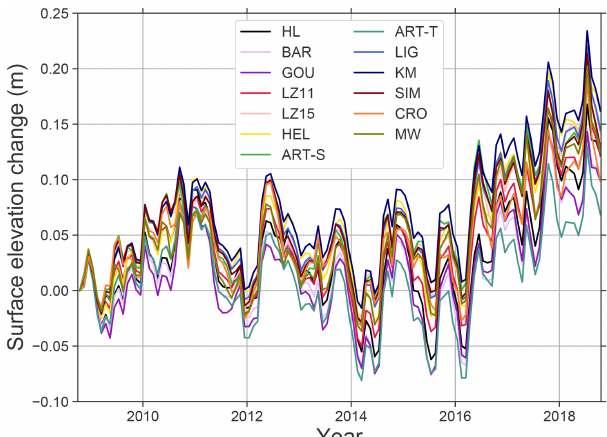
Figure 2. Model-predicted change in surface elevation at Summit, Greenland, from 2008 to 2018. This figure is also included in the Supplement as a layered PDF